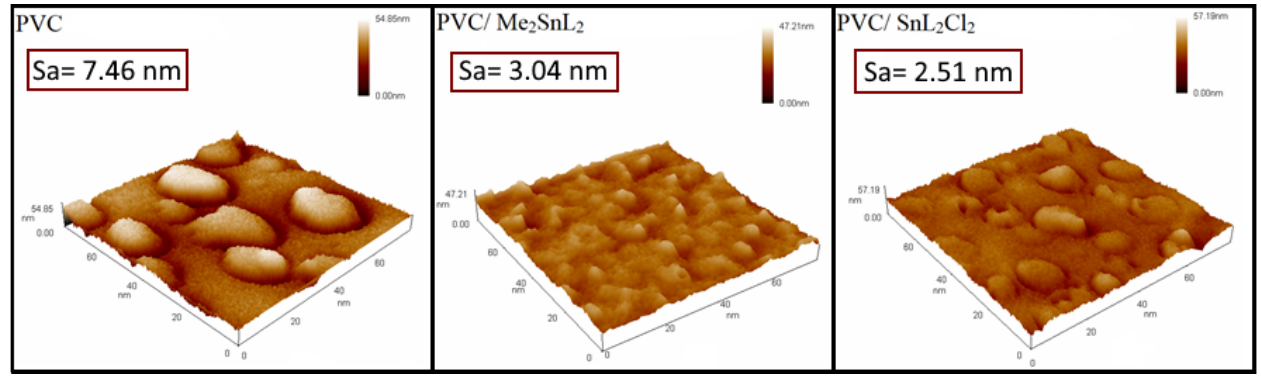
Figure 8. AFM images with Sa values of PVC films after irradiation for 300